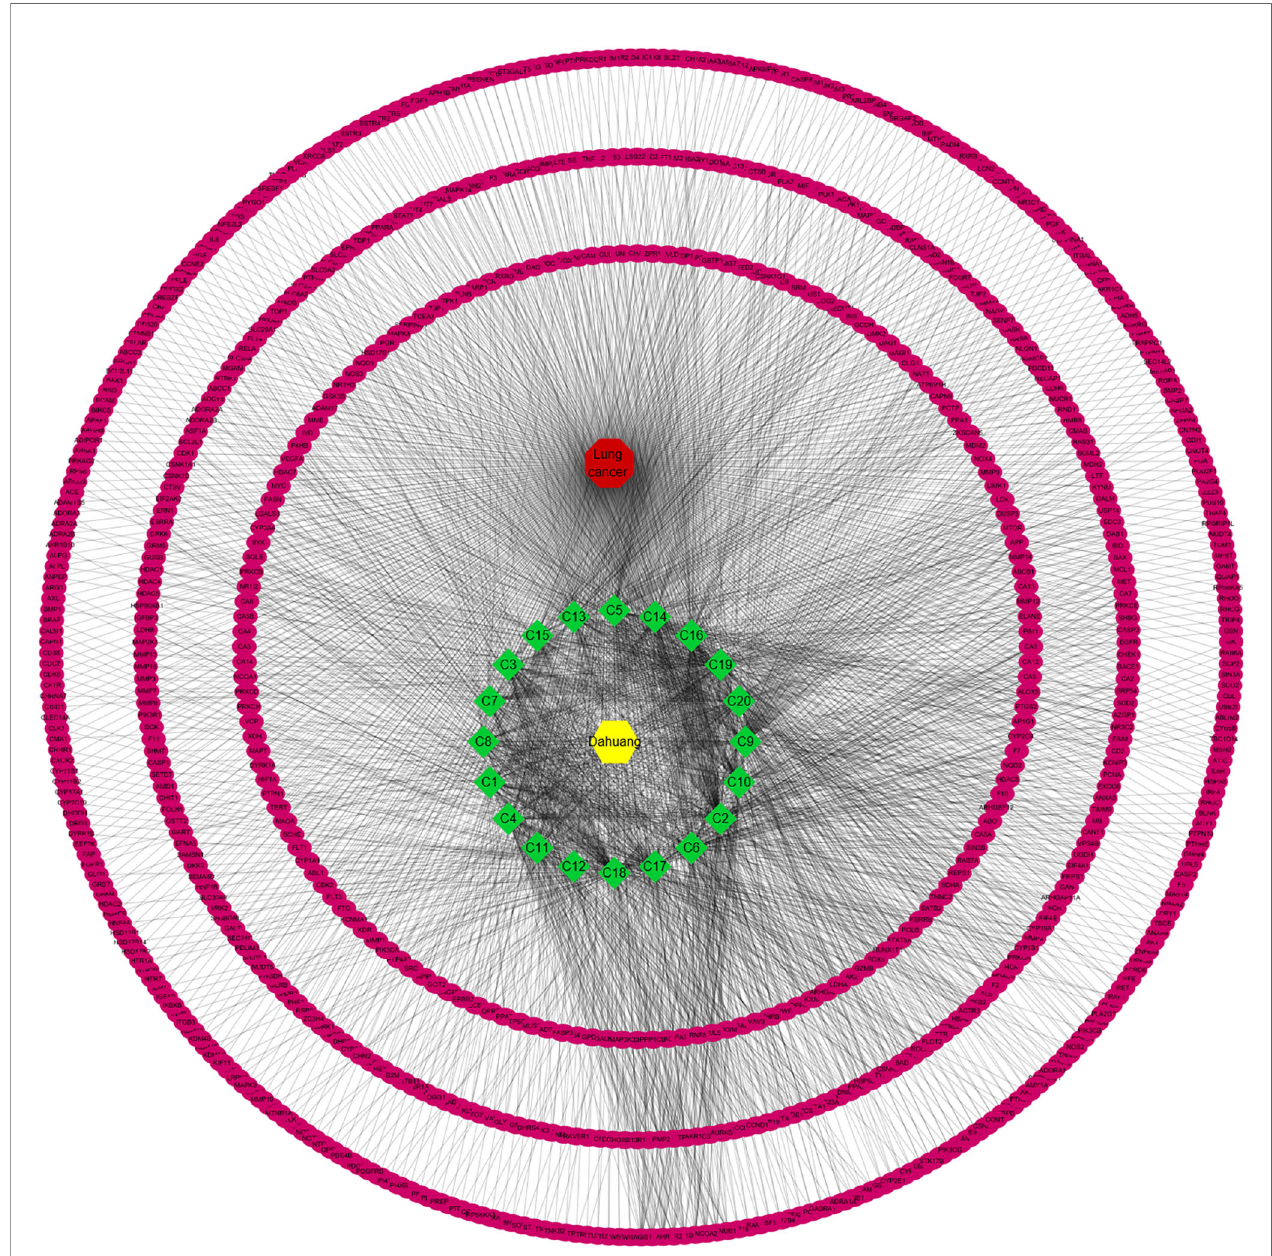
FIGURE 3 | Network analysis of targets. A total of data pairs of active compounds and disease target genes were prepared by R software, and the DDN was